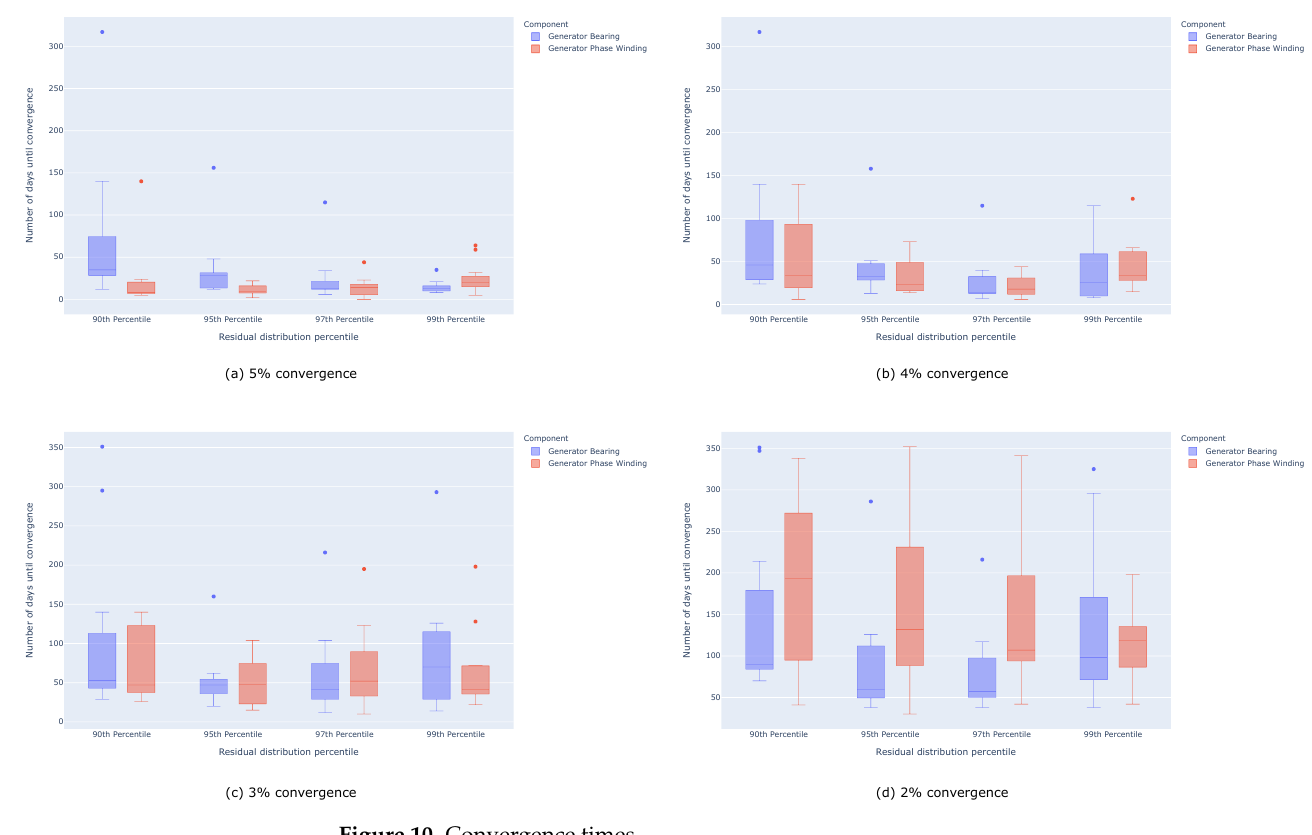
Figure 10. Convergence